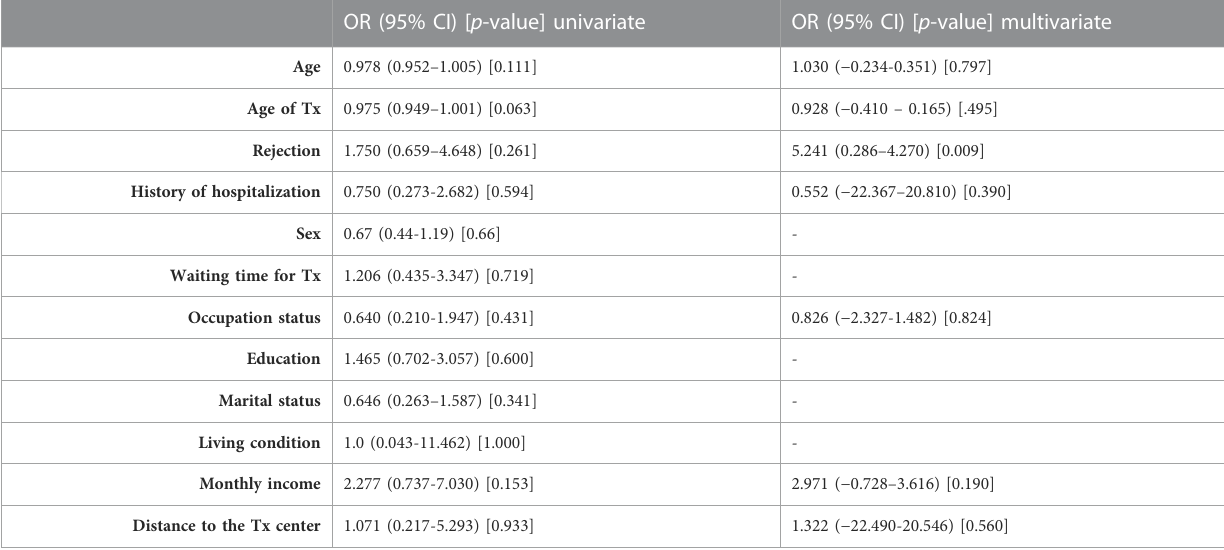
TABLE 2 Quantitative and qualitative risk factors regarding adherence among the liver transplant recipients (N = 122). OR (95% CI) [ p -value] univariate